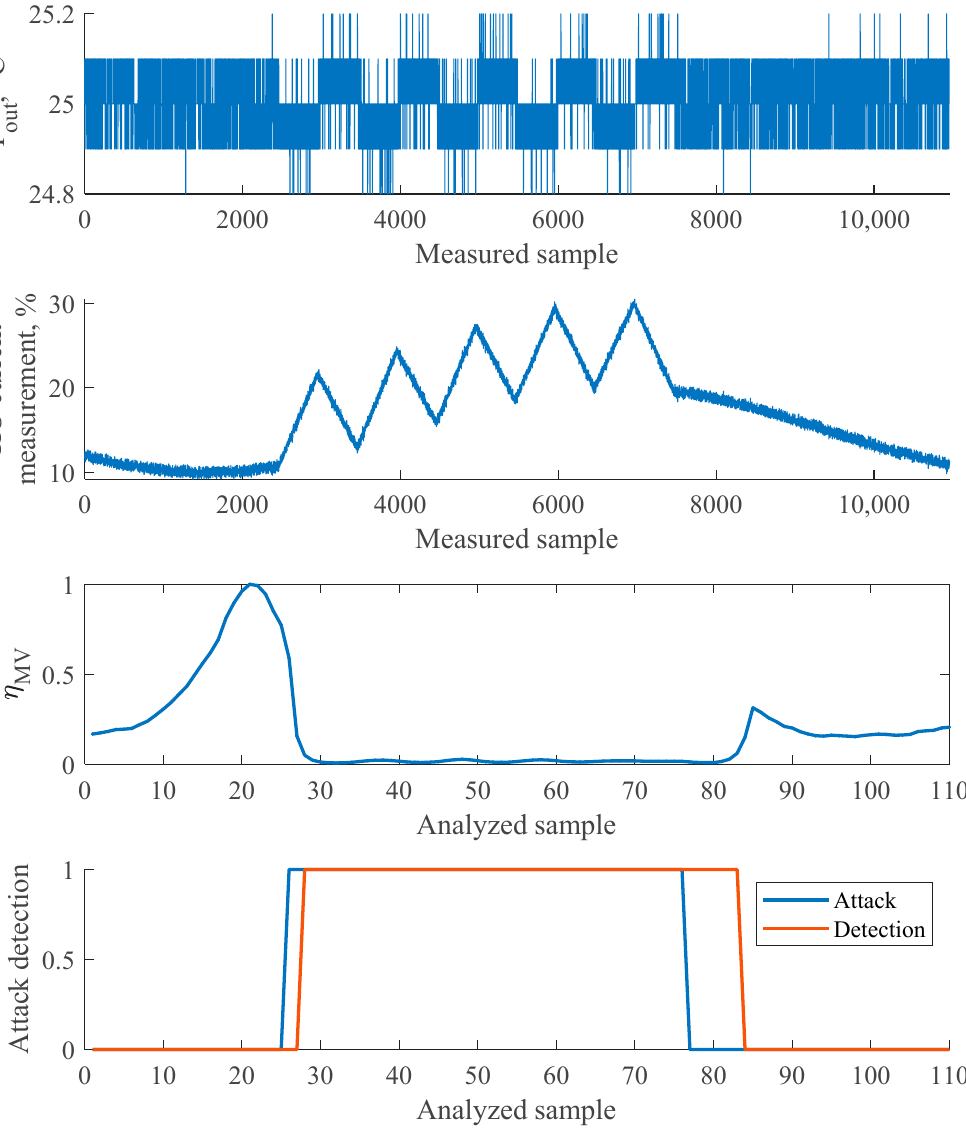
Figure 9. Triangular attack signal on top of a low-frequency natural sinusoidal disturbance.